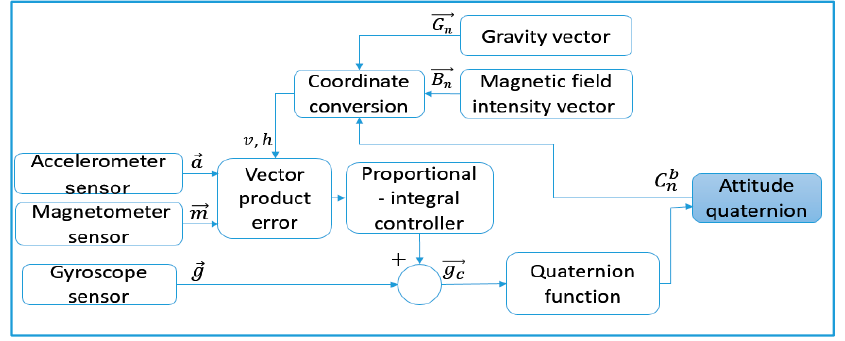
Figure 9. Calculation process of complementary filtering algorithm.